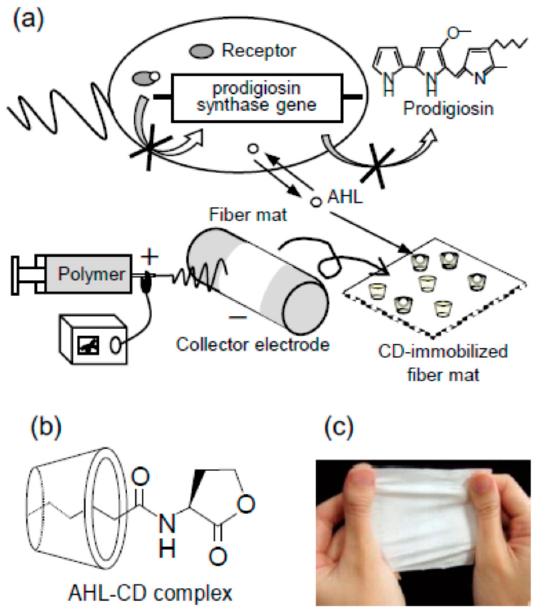
Figure 4. ( a ) Inhibition of Quorum Sensing-dependent prodigiosin production by CD-immobilized electrospun fiber mats; ( b ) Inclusion complex between CD and N -acyl- L -homoserine lactone (AHL); ( c ) Image of non-woven fiber mat electrospun from polyvinyl alcohol (PVA) solution. Reproduced from [94] with permission of The Materials Research Society of Japan.